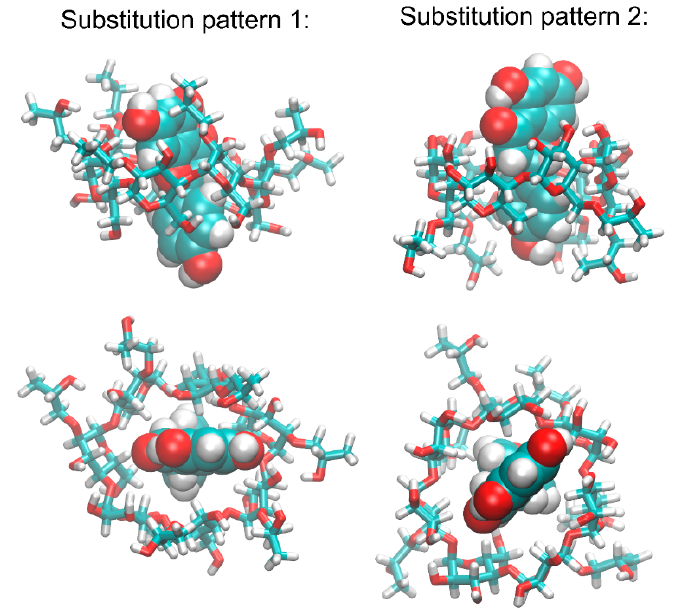
Figure 9. The exemplary structures of the NAR-HP- β -CD complexes, generated during MD simulations (view along two different axes). The two alternative substitution patterns of β -CD were con- sidered.